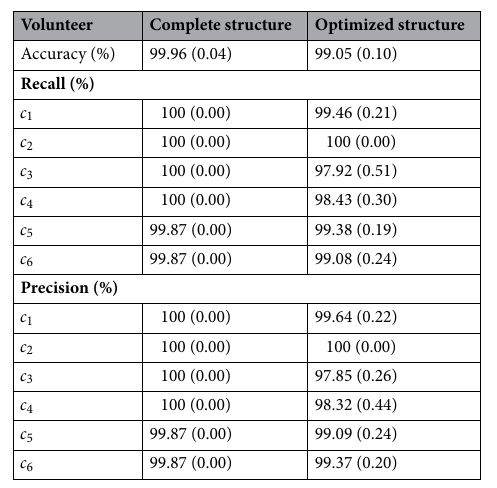
Table 2. Comparison between the classification results for volunteer 1 with complete structure and optimized